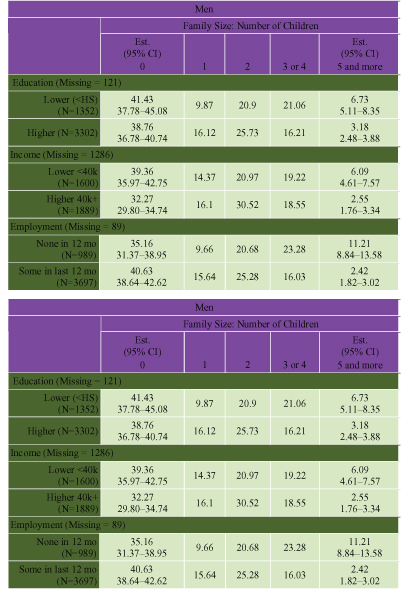
Showing the Sex Specific Distribution of Family Size by Education, Income and Employment Data Source: GSS Cycle 10, 1995